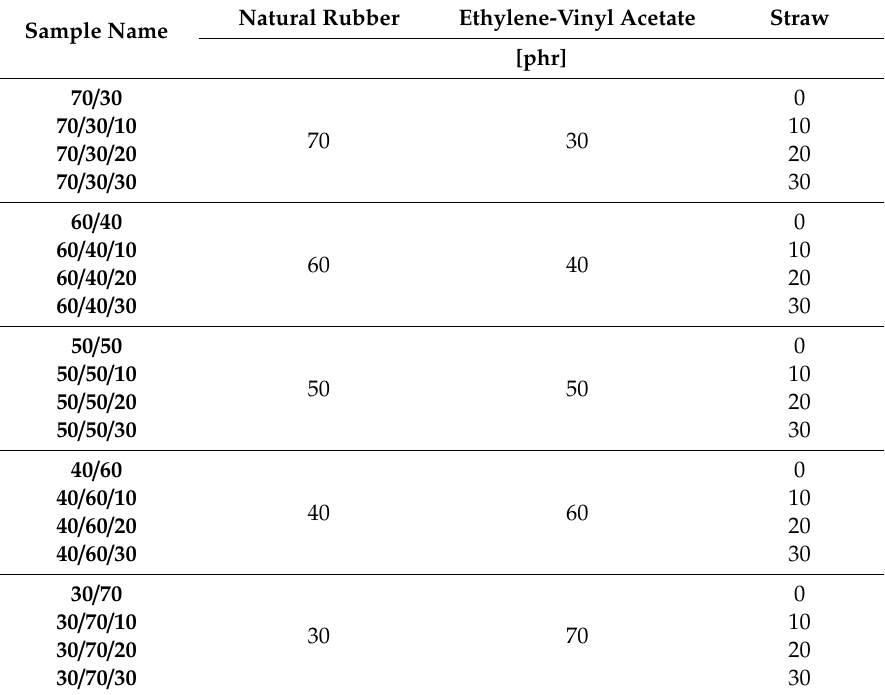
Table 1. The composition of polymer